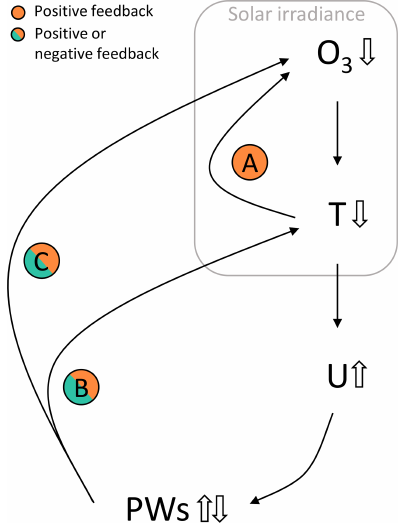
Figure 1. Scheme of possible feedbacks between ozone chem- istry and dynamics/transport. A negative anomaly in ozone (O 3 ) will lead to a negative anomaly in temperature ( T ) which fa- vors ozone depletion (A – positive feedback). It also increases the strength of the polar night jet ( U ). Depending on the strength of the background westerlies, an increase in U can lead to either an increase or decrease in upward planetary wave propagation (PWs). A strong (weak) westerly background wind can lead to a decrease (increase) in PWs, which is connected to a less (more) disturbed polar vortex, coupled to (B) a cooling (warming) of the polar vor- tex, and (C) to less (more) transport of ozone into the polar vortex. Consequently, strong (weak) background westerlies are connected to positive (negative) feedbacks between ozone chemistry and dy- namics/transport (B and